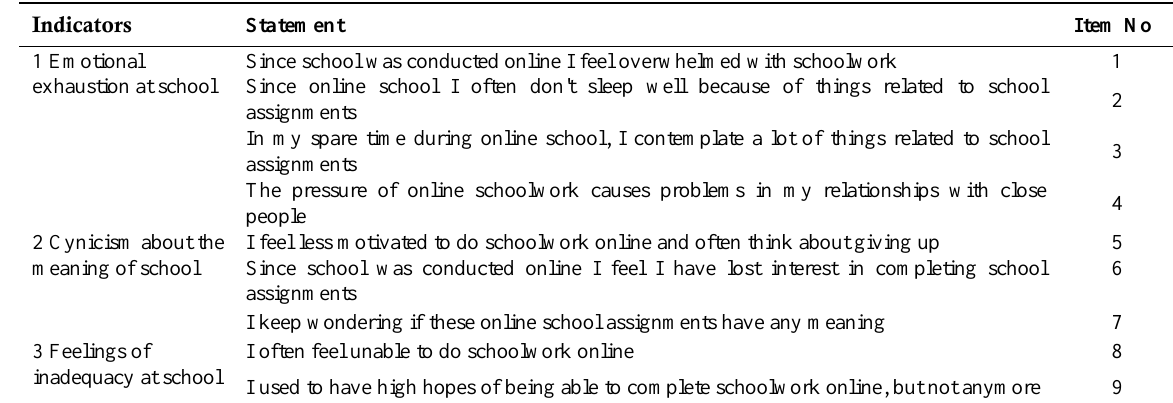
Table 1. Indicators and Items of the School Burnout Inventory (SBI) Scale Indicators Statement Item